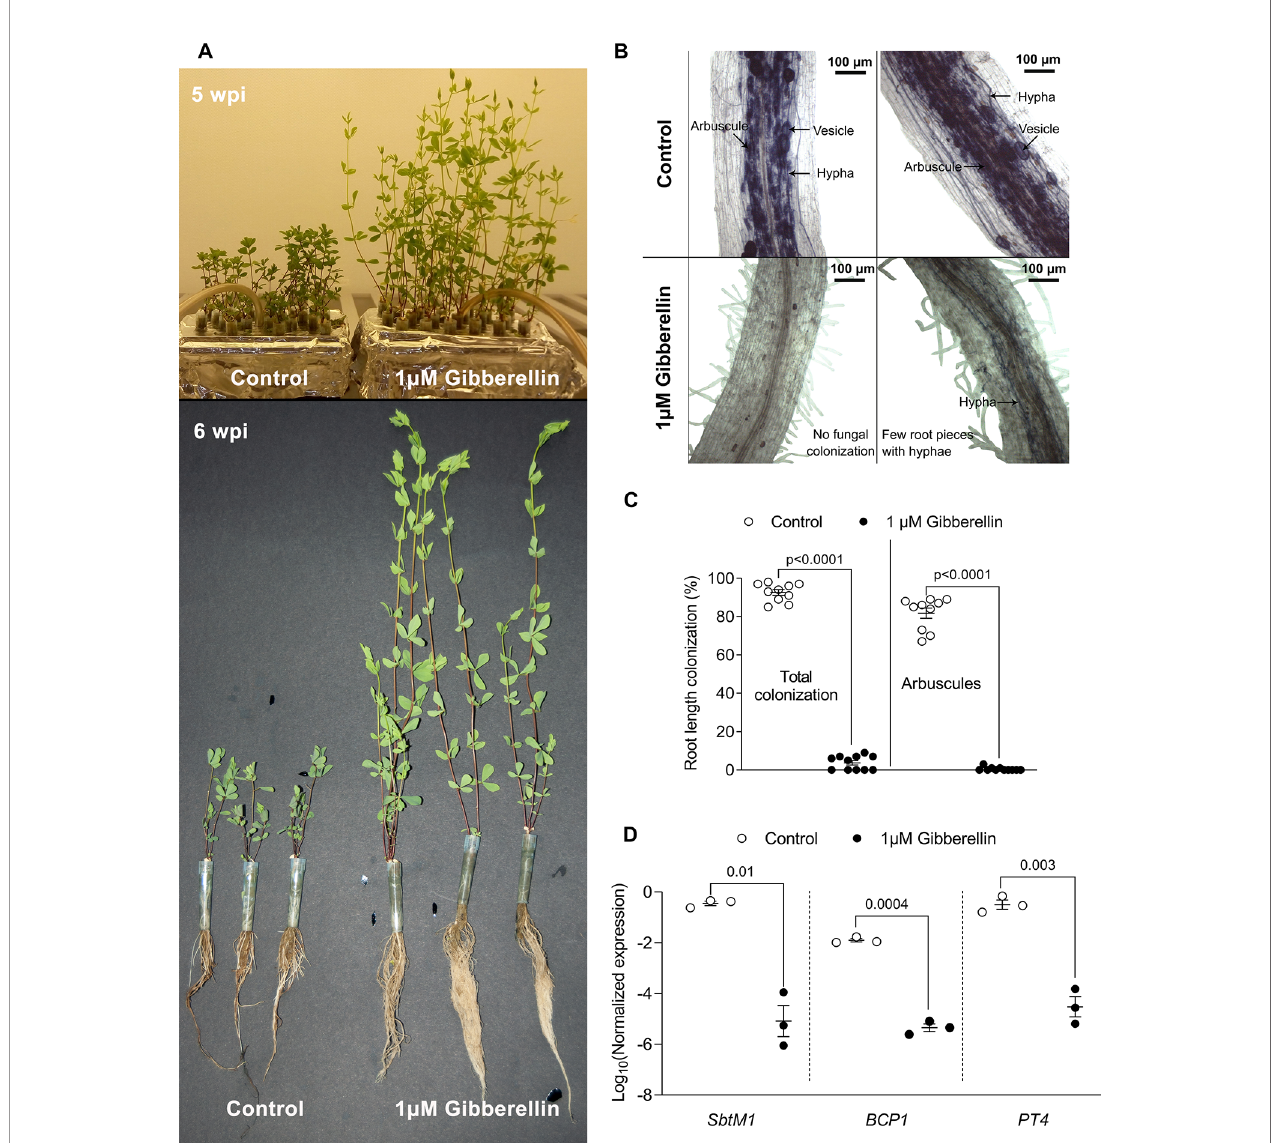
FIGURE 3 | Pharmacological assay in tip-wick hydroponics. (A) Effect of 1 µM gibberellin treatment on Lotus japonicus growth in tip-wick hydroponics; (B) 1 m M gibberellin suppresses root colonization by Rhizophagus irregularis . The fungus inside the roots was stained with acid ink. (C) Effect of 1 m M gibberellin on percent root length colonization by R. irregularis (statistical analysis: Mann-Whitney test, n = 10 separate plants in one tip-box). (D) Effect of 1 m M gibberellin on AM marker gene expression (statistics: t-test with Welch's correction, n = 3 consisting of a pool of two root systems each, with the six plants grown in one tip-box). For all analyses, plants were harvested at 6